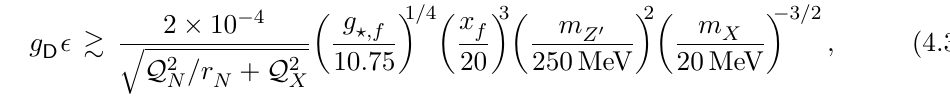
Figure 4 . Two-loop functions J out, the J ∼ O (0 . 1) in the DM mass range of 1 , 2